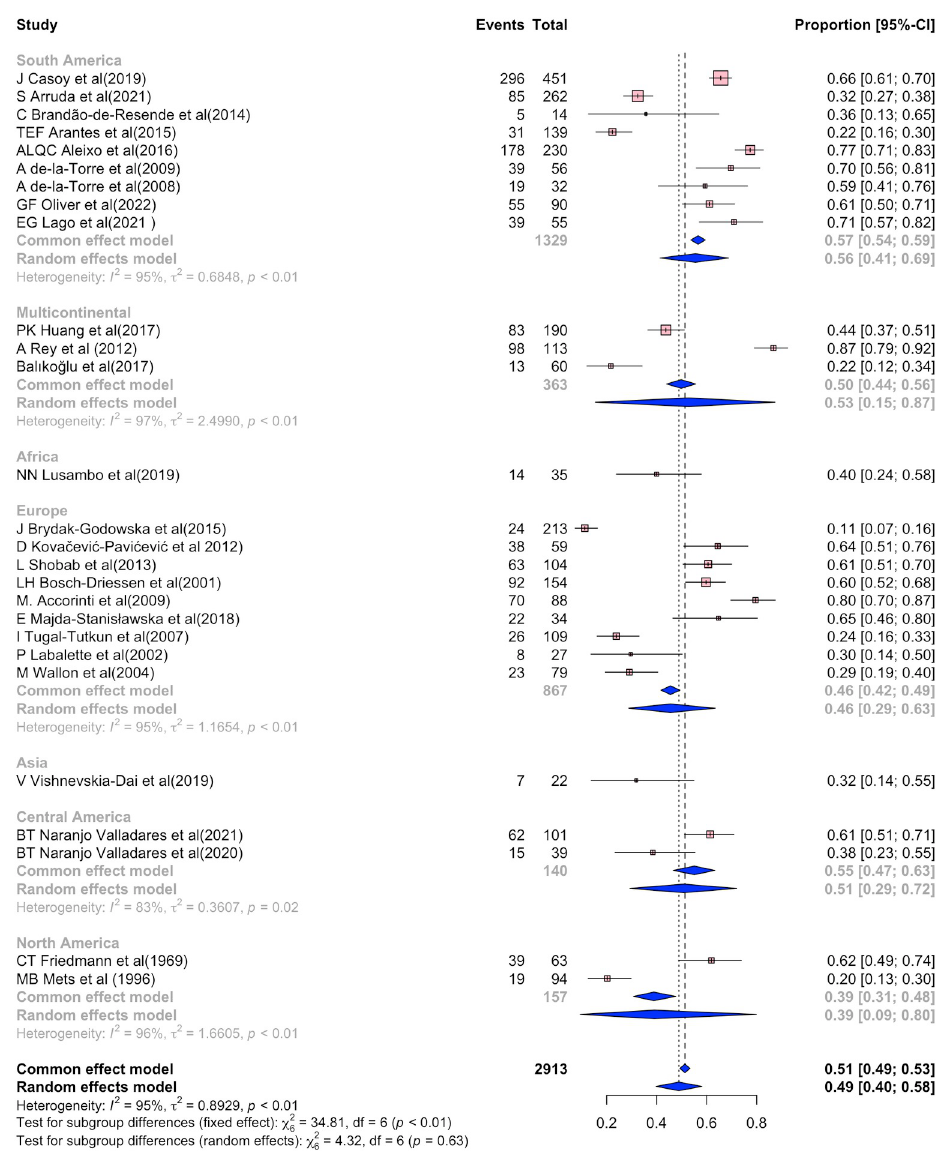
Fig 4. Frequency of recurrence segmented by